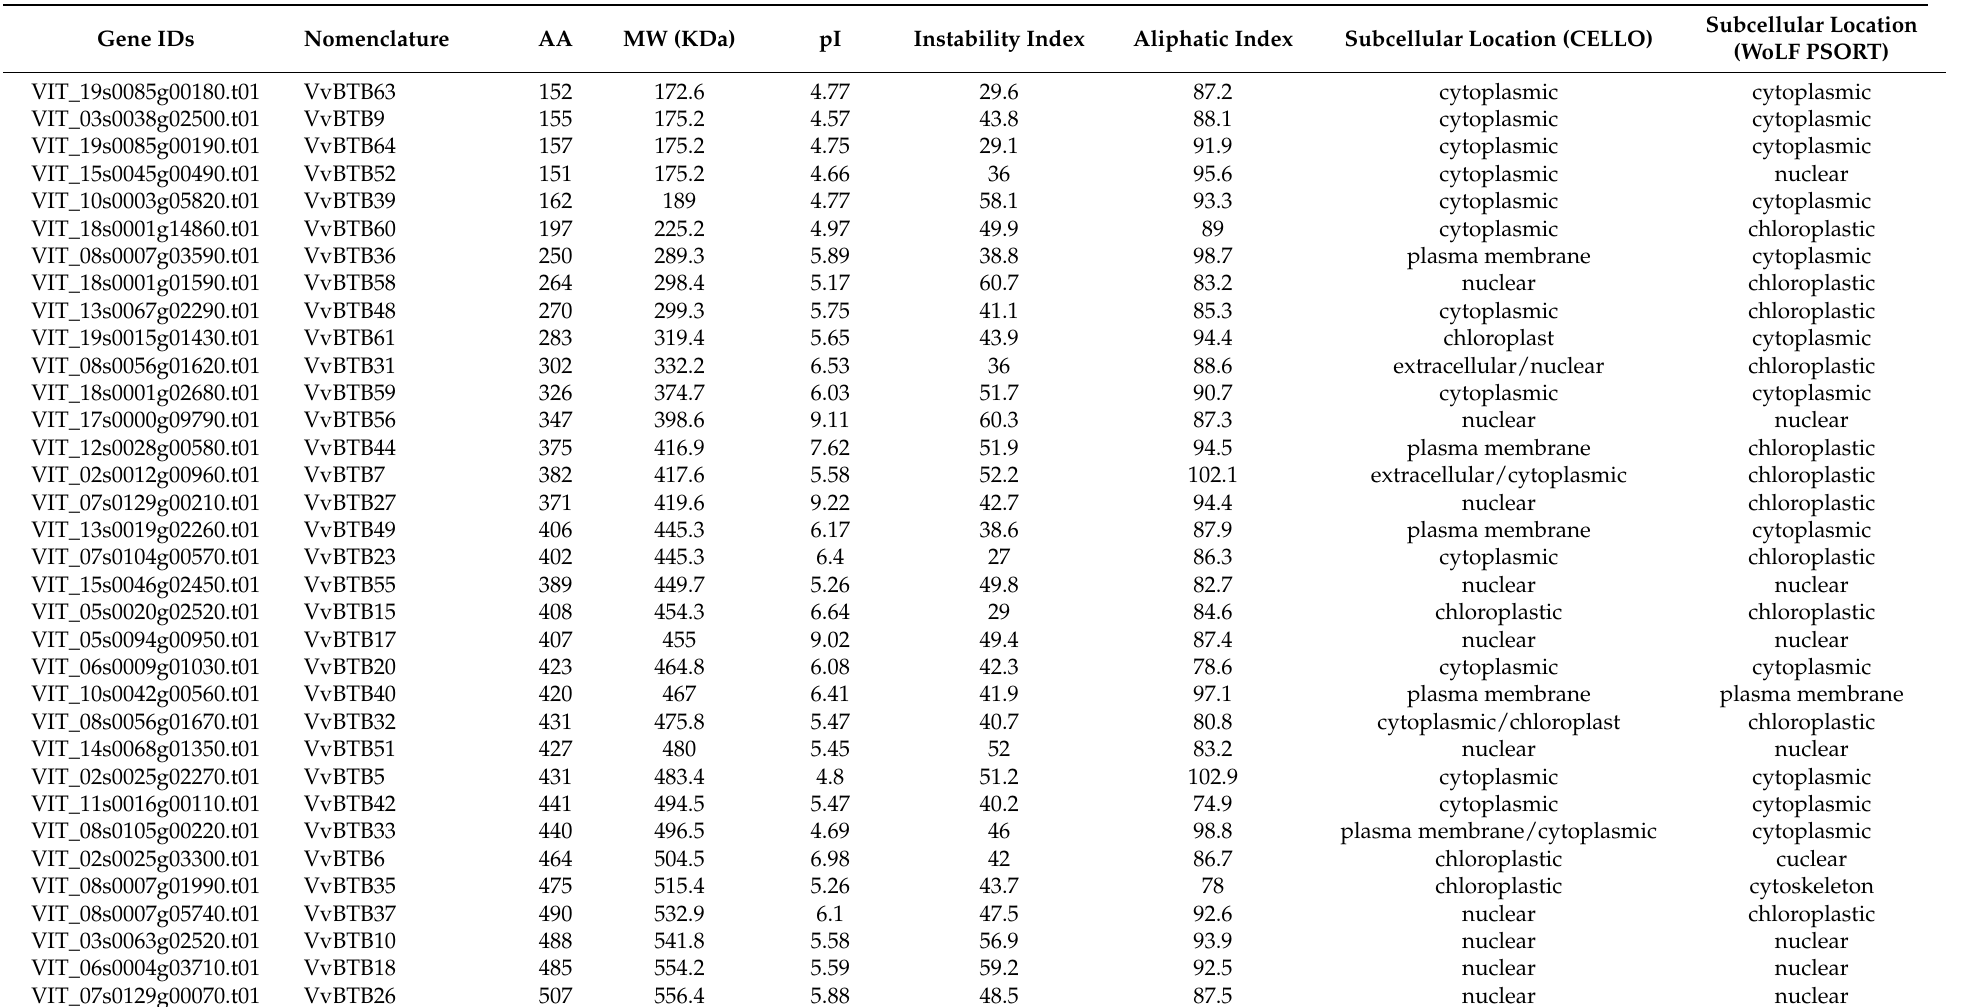
Table 1. Physicochemical properties and sub-cellular localization of BTB family in V.vinifera (AA: amino acid; MW: molecular weight; pI: isoelectric